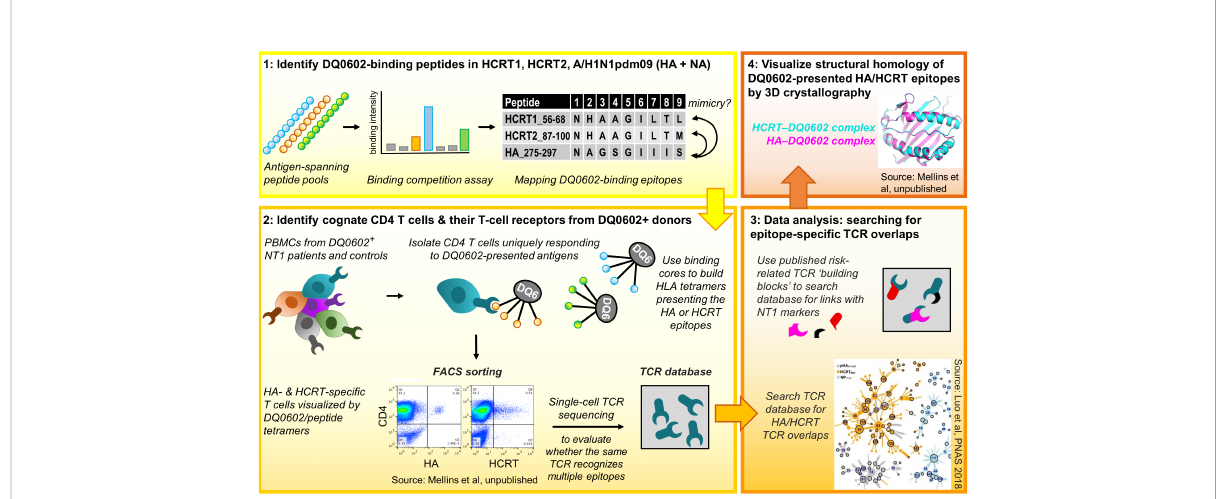
FIGURE 1 Research work fl ow [see refs (31, 64) for details]. Figure represents the four work fl ow steps and tenets. Step 1: Pools of overlapping 15-mer peptides spanning the A/H1N1pdm09 haemagglutinin (HA)/neuraminidase (NA), hypocretin (HCRT)1 and HCRT2 sequences were used to measure binding to DQB1*0602 (DQ0602). Then, the peptides ’ uniqueness for A/H1N1pdm09 and putative similarities between the HA and HCRT sequences were determined, with peptide sequence homology considered a fi rst indication for putative molecular mimicry. Step 2: using DQ0602-positive donor CD4 + T cells and the human leukocyte antigen class II (HLA-II) tetramers, the peptides from Step 1 were assayed for their abilities to promote T-cell activation and recognition. Isolated tetramer-binding cells were subjected to single-cell T-cell receptor (TCR) sequencing. Step 3: TCR databases were inspected for cross-reactivity and the presence of type-1 narcolepsy (NT1)-associated mutations. The inset [from ref (31)] shows the clustering and overlap of TCR sequences found using tetramers with peptides from nucleoprotein control (NP; blue), HCRT (orange), or HA (grey), allowing to identify cross-reactive TCR families. In Step 4, X-ray diffraction and crystallography analyses were used to investigate structural/conformational similarities between the peptides bound to the DQ0602 groove, to complement the sequential homology data from Step 1. PBMCs, peripheral blood mononuclear cells. FACS, fl uorescence-activated cell sorting. Data are shown for illustrative purposes